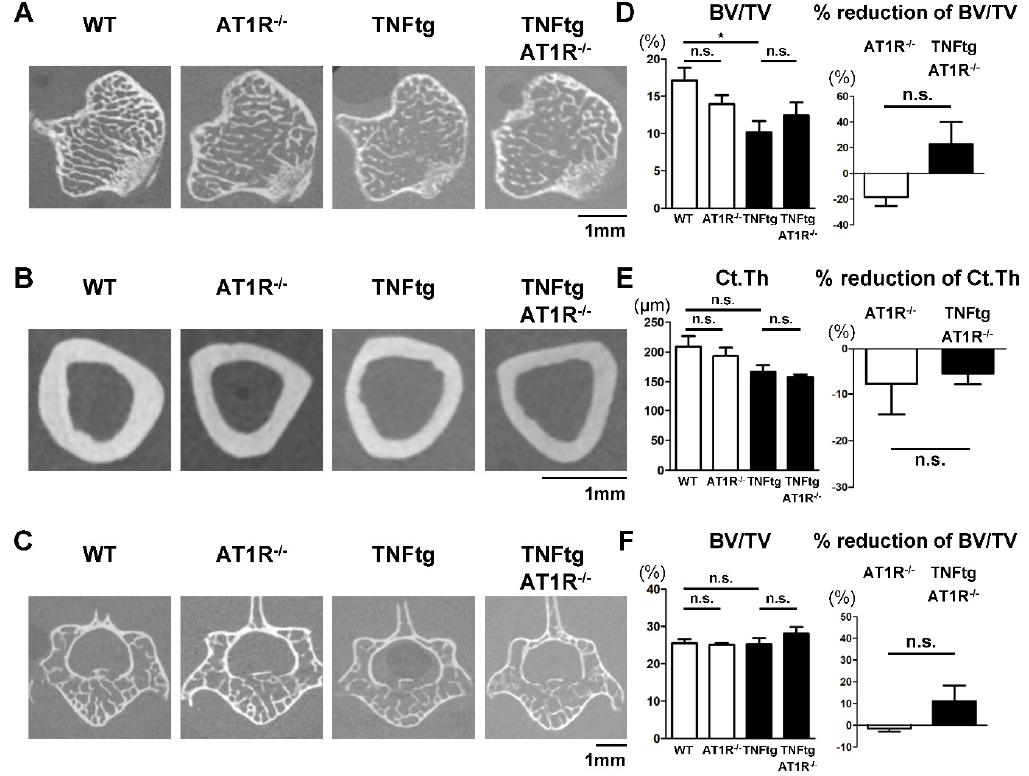
Figure 6. Effect of AT1R deficiency on bone properties of the trabecular and cortical bones in tumor necrosis factor-transgenic (TNFtg) mice. TNFtg mice were crossed with AT1R-deficient (AT1R − / − ) mice. WT ( n = 9), AT1R − / − ( n = 7), TNFtg ( n = 12), and TNFtg AT1R − / − ( n = 8) male mice were analyzed at the age of 16 weeks. Representative 2D micro-CT images of the tibia trabecular bone ( A ), the tibia cortical bone ( B ), and the trabecular bone of the spine (fifth lumbar vertebra) ( C ). ( D ) Bone volume per total volume (BV/TV) and reduction rate of the tibia trabecula bone. ( E ) Cortical thickness (Ct.Th) and reduction rate of the tibia midshaft. ( F ) Bone volume per total volume (BV/TV) and reduction rate of the fifth lumbar vertebral trabecular bone. Values are the mean ± SEM. n.s., not significant. *, p < 0.05.